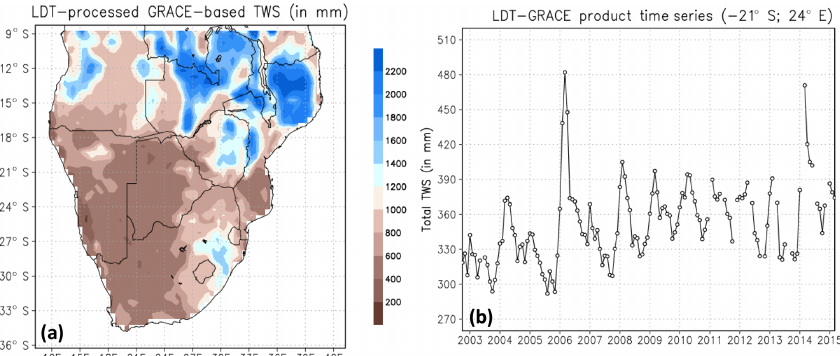
Figure 6. Examples of LDT-processed GRACE-based total TWS (in mm). (a) Plot of the LDT-processed TWS data for the southern African region for February, 2011 and (b) a time-series plot of the TWS data for years 2003–2015 and latitude of − 21 ◦ S and longitude of 24 ◦